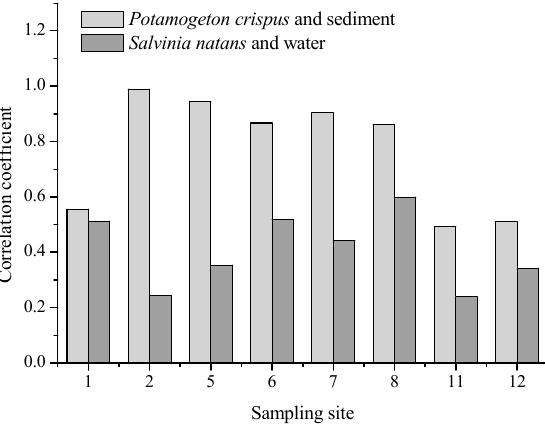
Figure 3. Correlation coe ffi cients of heavy metals between the plants and water (or sediments).